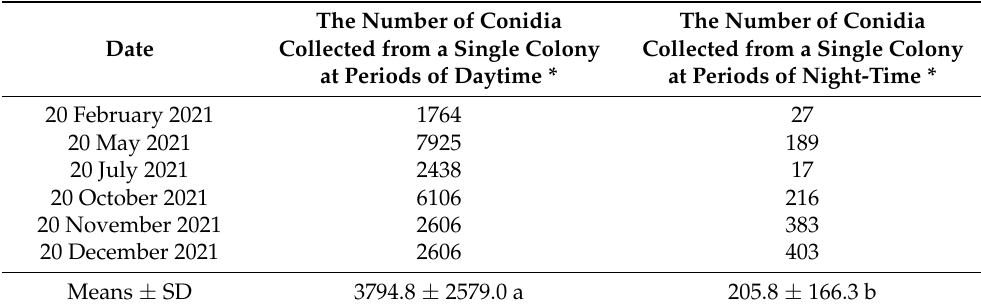
* Daytime and night-time periods each month were represented in Table 2. Different letters (a, b) indicated significant differences ( p < 0.05, Tukey’s